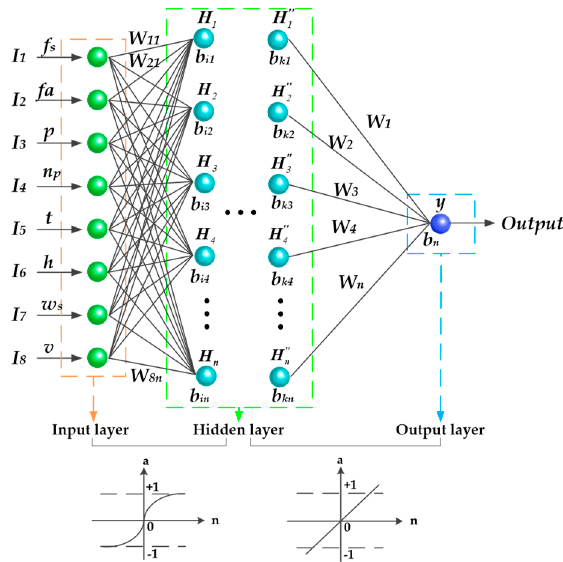
Figure 1. The topological structure of BP neural network. Note: I 1 ~ I 8 are input layer neurons; H 1 ~ H n and H” 1 ~ H” n are hidden layer neurons; n is the number of the hidden layer neurons. y is output layer neuron. W kn represents the weight between the k -th node of the input layer and the n -th node of the hidden layer. b in represents the bias between the i -th node of the input layer and the n -th node of the hidden layer. b kn represents the bias between the k -th node of the hidden layer and the n -th node of the hidden layer. W n represents the weight between the n -th node of the hidden layer and the output layer. b n represents the bias between the n -th node of the hidden layer and the output layer.